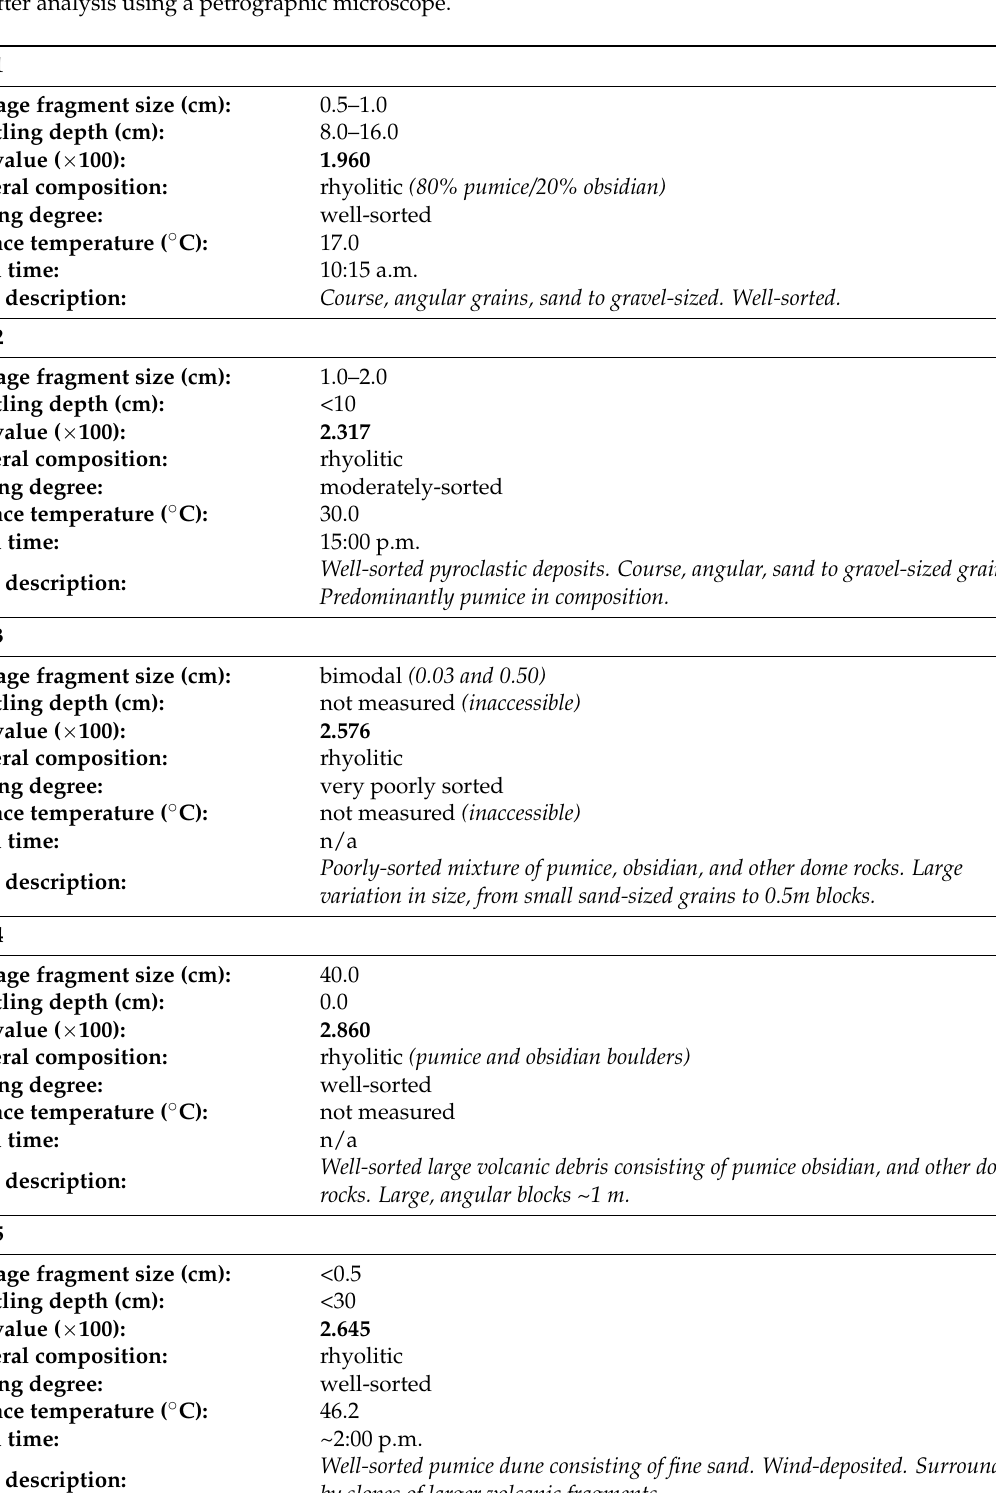
Table 2. Characterization of the 13 targeted field sites in the study. Sorting and grain size determined after analysis using a petrographic